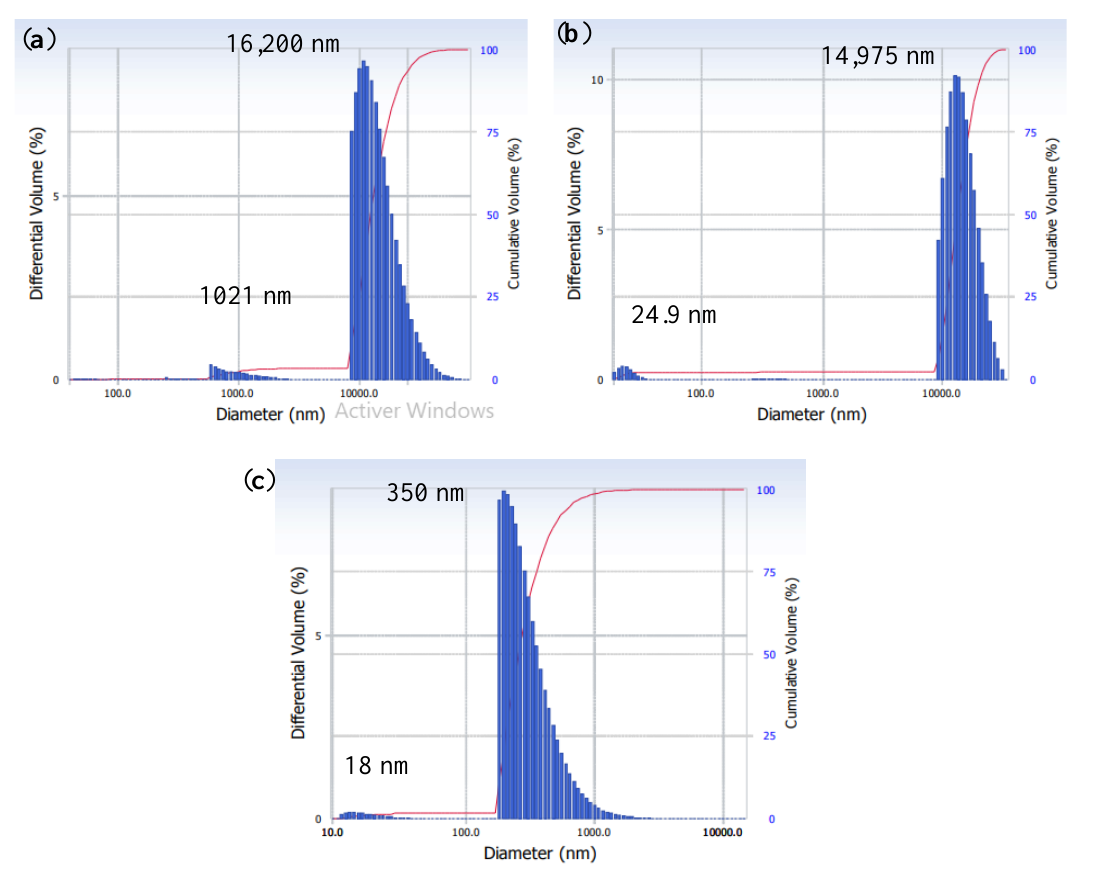
Figure 3. Particle size distribution of SA-BSA solution at ( a ) pH 4, ( b ) pH 6, and ( c ) pH 8.